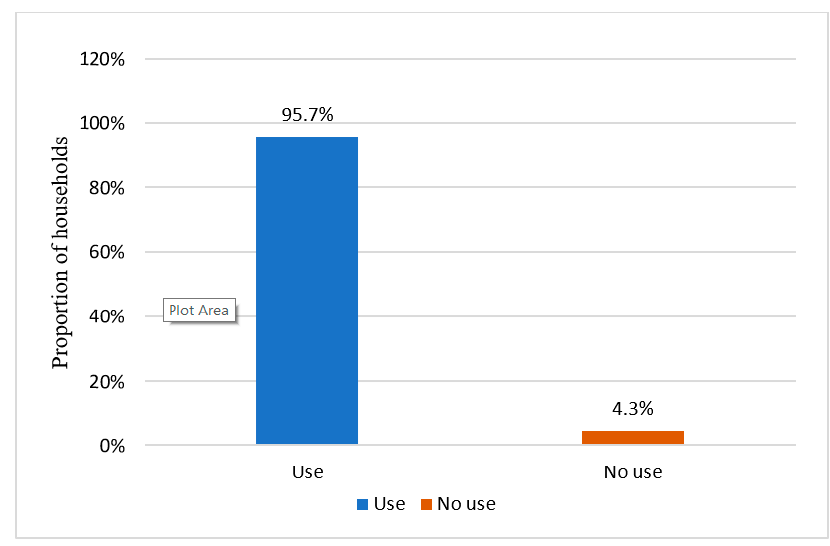
Figure 5. Proportion ( N = 210) of households with toilet use.